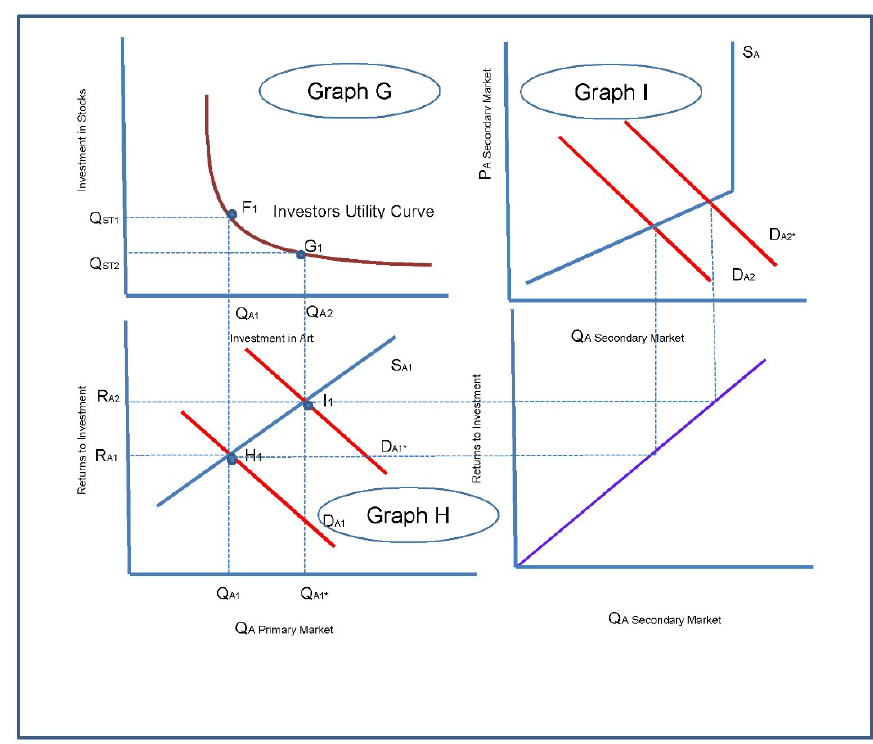
FIGURE 6: The effect of changes in the primary art market into the secondary art market Source: Authors’